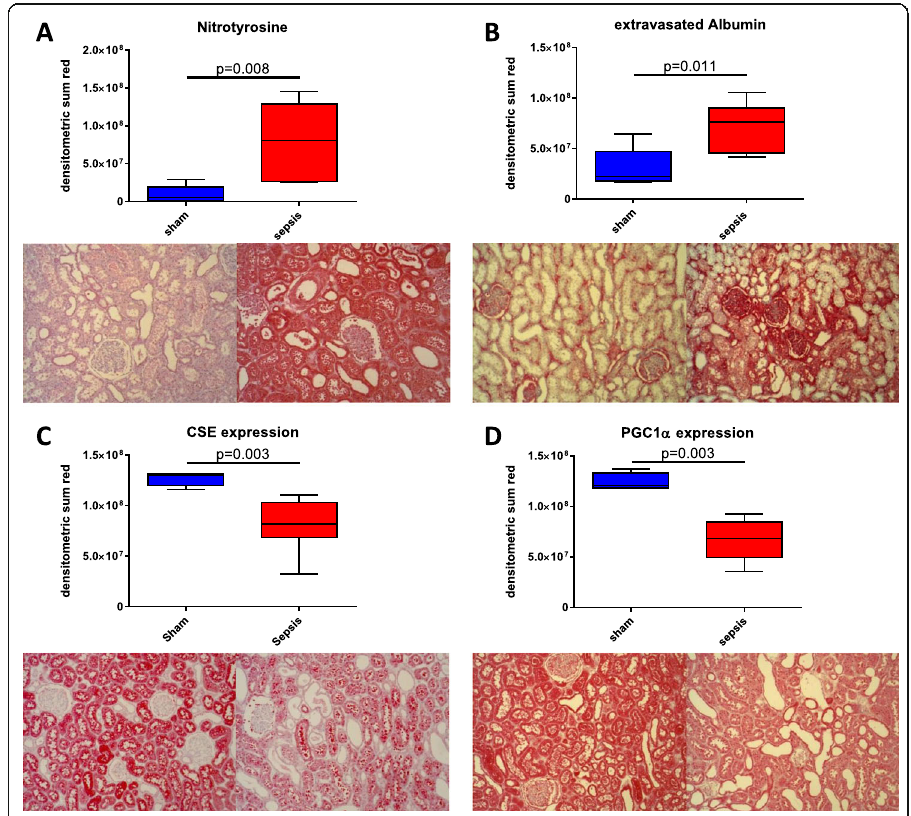
Fig. 3 Kidney specimens stained for nitrotyrosine formation (sham n =5, sepsis n =8) ( a ), albumin extravasation (sham n =5, sepsis n =8) ( b ), CSE expression (sham n =5, sepsis n =7) ( c ), and PGC1 α expression (sham n =5, sepsis n =8) ( d ). Top quantitative densitometric sum (red), bottom exemplary pictures for sham and sepsis, respectively, in ×10